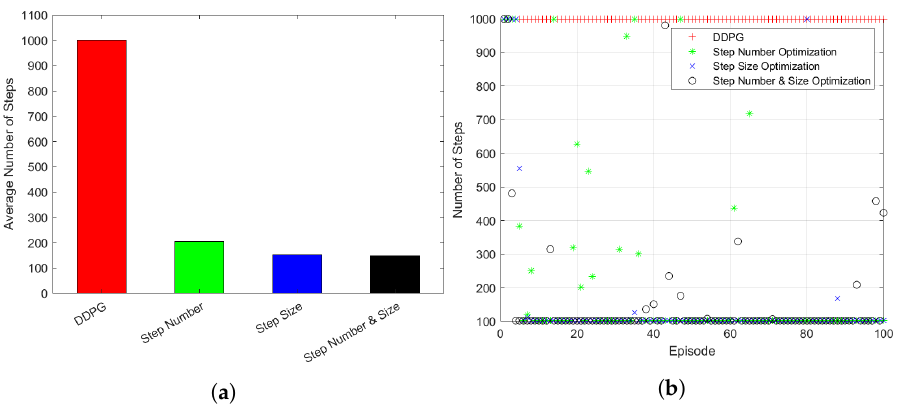
Figure 8. Change of steps after step optimization: ( a ) Average Number of Steps. ( b ) Number of Steps used in Episode.